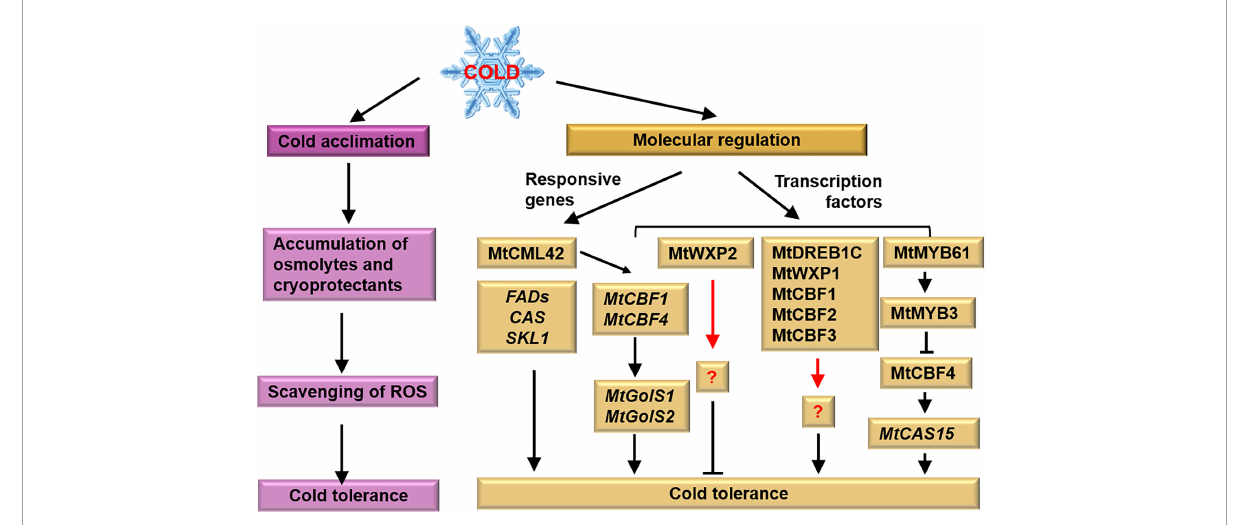
FIGURE3 Tolerant mechanism of M. truncatula to cold stress. M. truncatula enhances its cold tolerance after cold acclimation. Meanwhile, cold responsive genes and transcription factors associated with cold tolerance have been identified. Pink and yellow boxes represent physiological and molecular responses, respectively. The black arrows represent the targets, the red arrows represent the unknown factors and the cross-lines mean suppression.